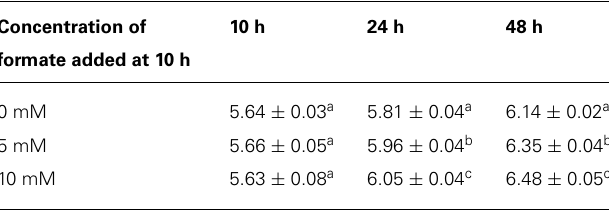
Table 5 | Effect of exogenous formate addition on pH of fermentation medium. Concentration of